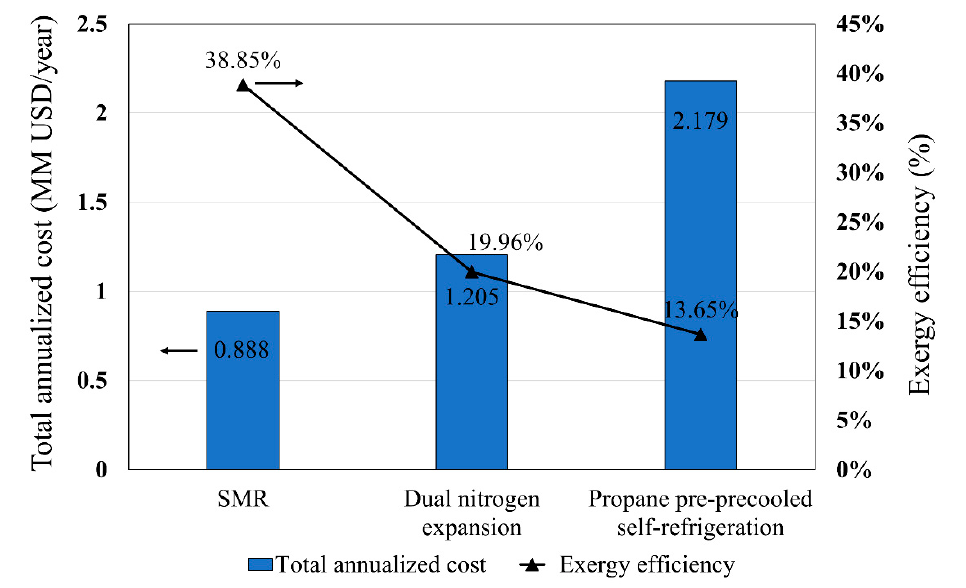
Figure 7. Exergy efficiency and the total annualized cost for each process. Figure 7. Exergy e ffi ciency and the total annualized cost for each